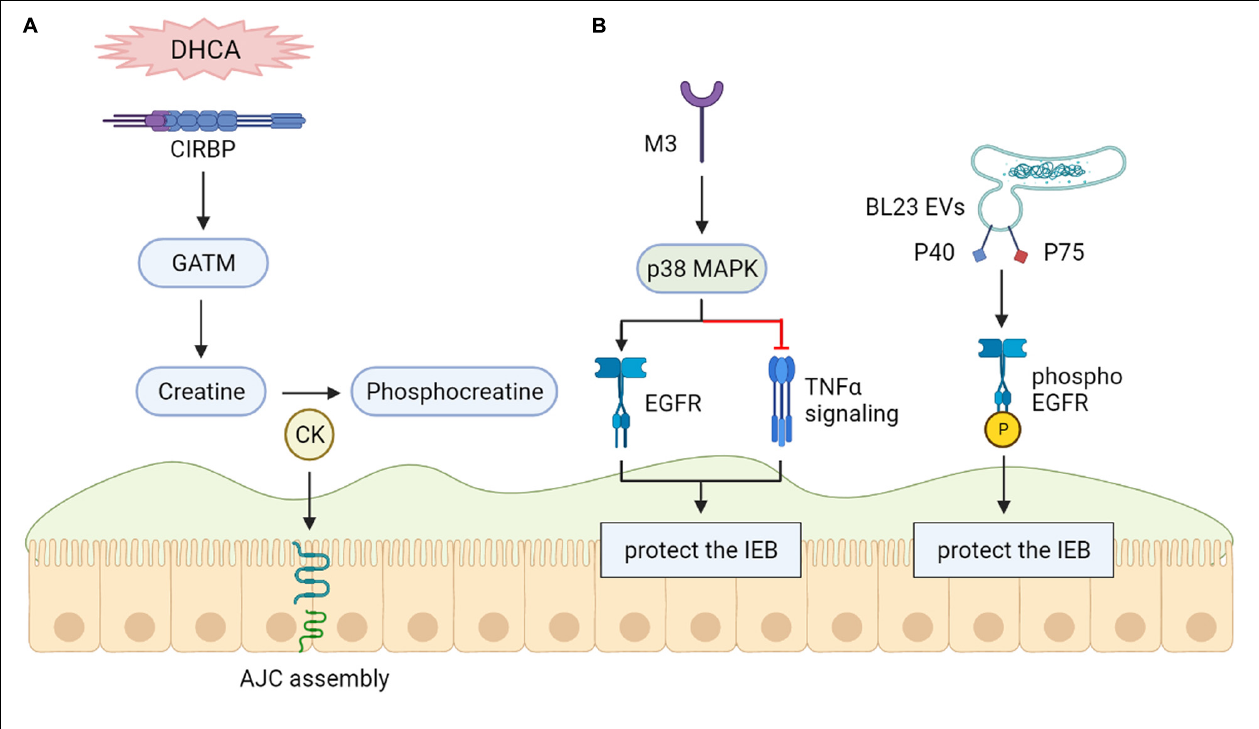
FIGURE 4 | (A) Cold-inducible RNA-binding protein (CIRBP) protect the intestinal epithelial barrier. CIRBP is related to intestinal epithelial barrier maintenance during DHCA. (B) Epidermal growth factor receptors (EGFR) protect the intestinal epithelial barrier. The maintenance of epithelial barrier function may be helped by M3 receptor-induced activation of p38 MAPK through activation of EGFR. Phosphorylation of the epidermal element factor receptor (EGFR) can be induced by lactobacillus casei BL23 extracellular vesicles (BL23 EVs) because of proteins P40 and P75 that are bound to their